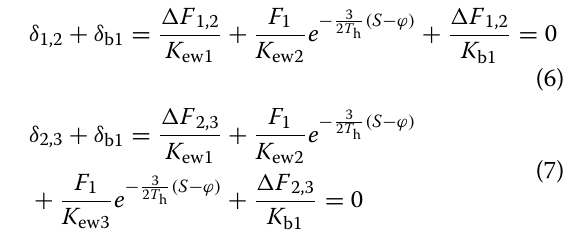
From the compatibility conditions of the elastic deforma- tion, Eqs. (6) and (7) hold using the bolt elongation δ b1 :